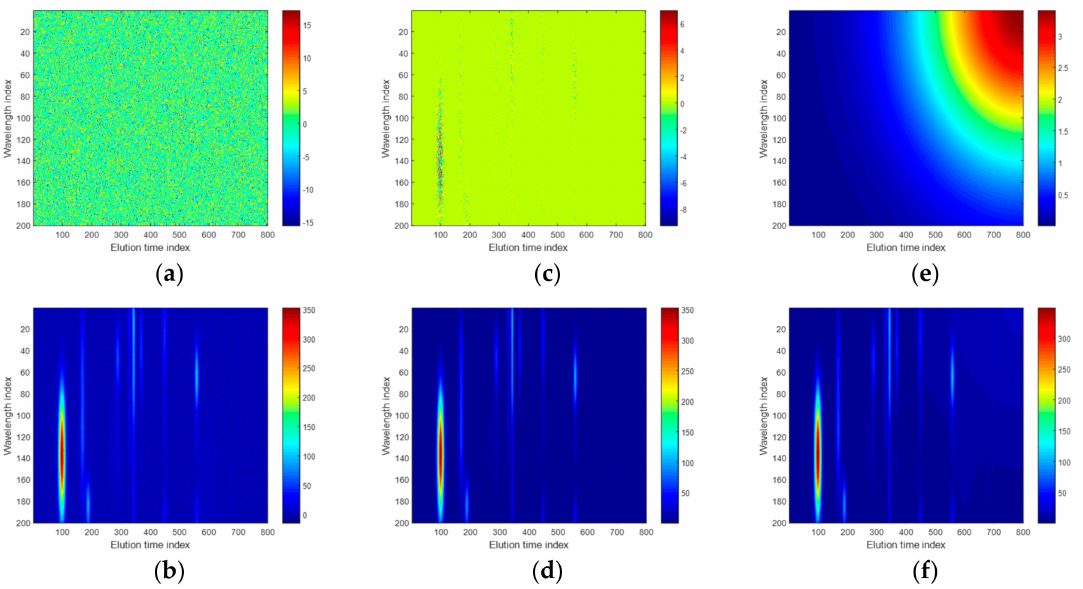
Figure 5. ( a ) Simulated Gaussian noise and ( b ) resulting second-order chromatographic signal, ( c ) simulated heteroscedastic noise, and ( d ) resulting second-order chromatographic signal, ( e ) simulated baseline, and ( f ) resulting second-order chromatographic